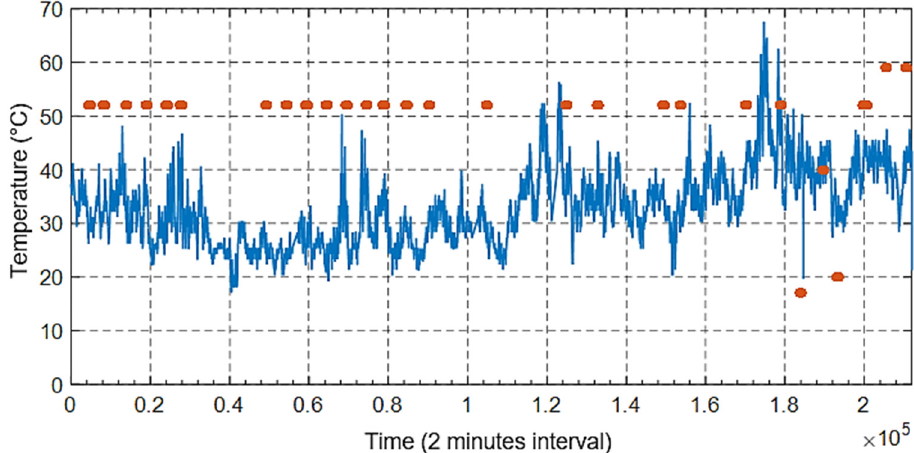
Figure 29. Online (blue) and offline (orange) temperature evolution.